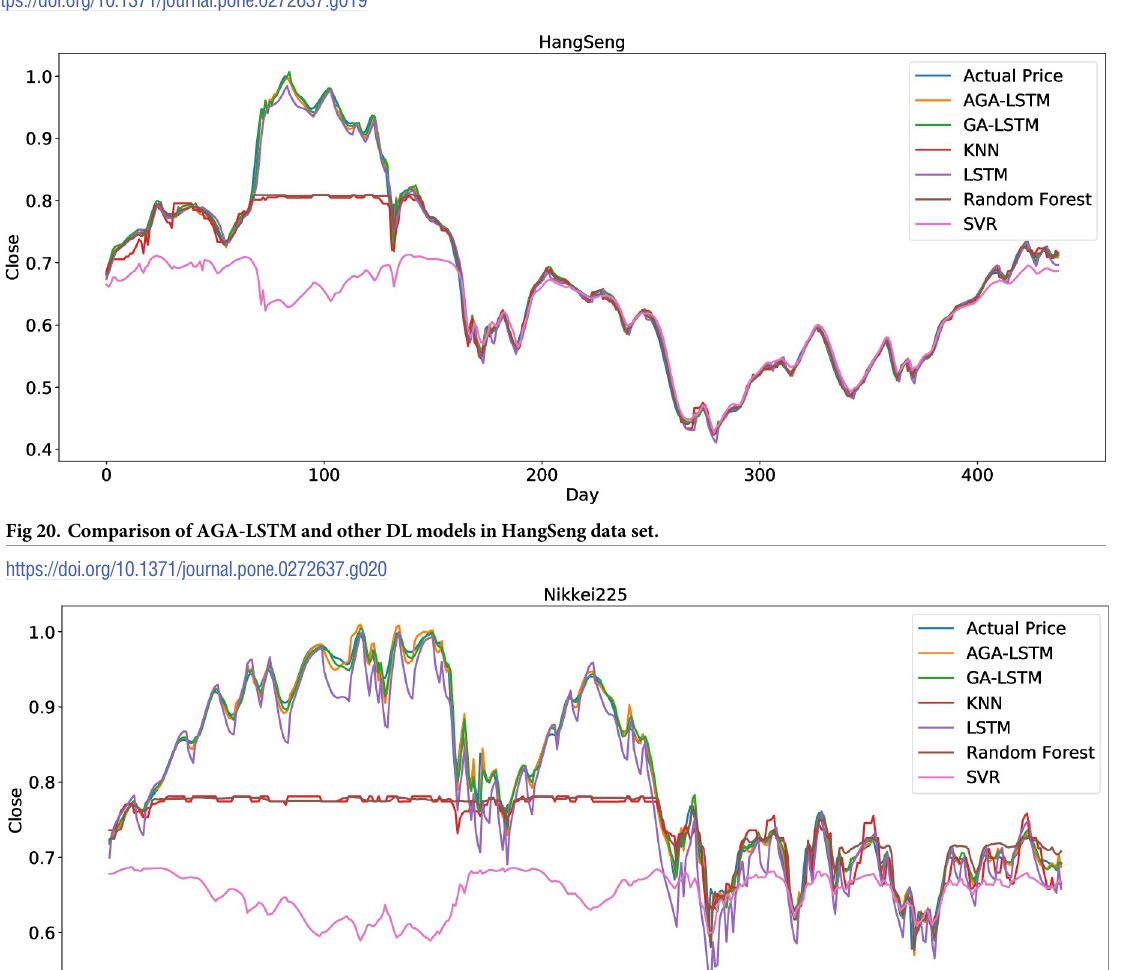
Fig 19. Comparison of AGA-LSTM and other DL models in S&P500 data set.